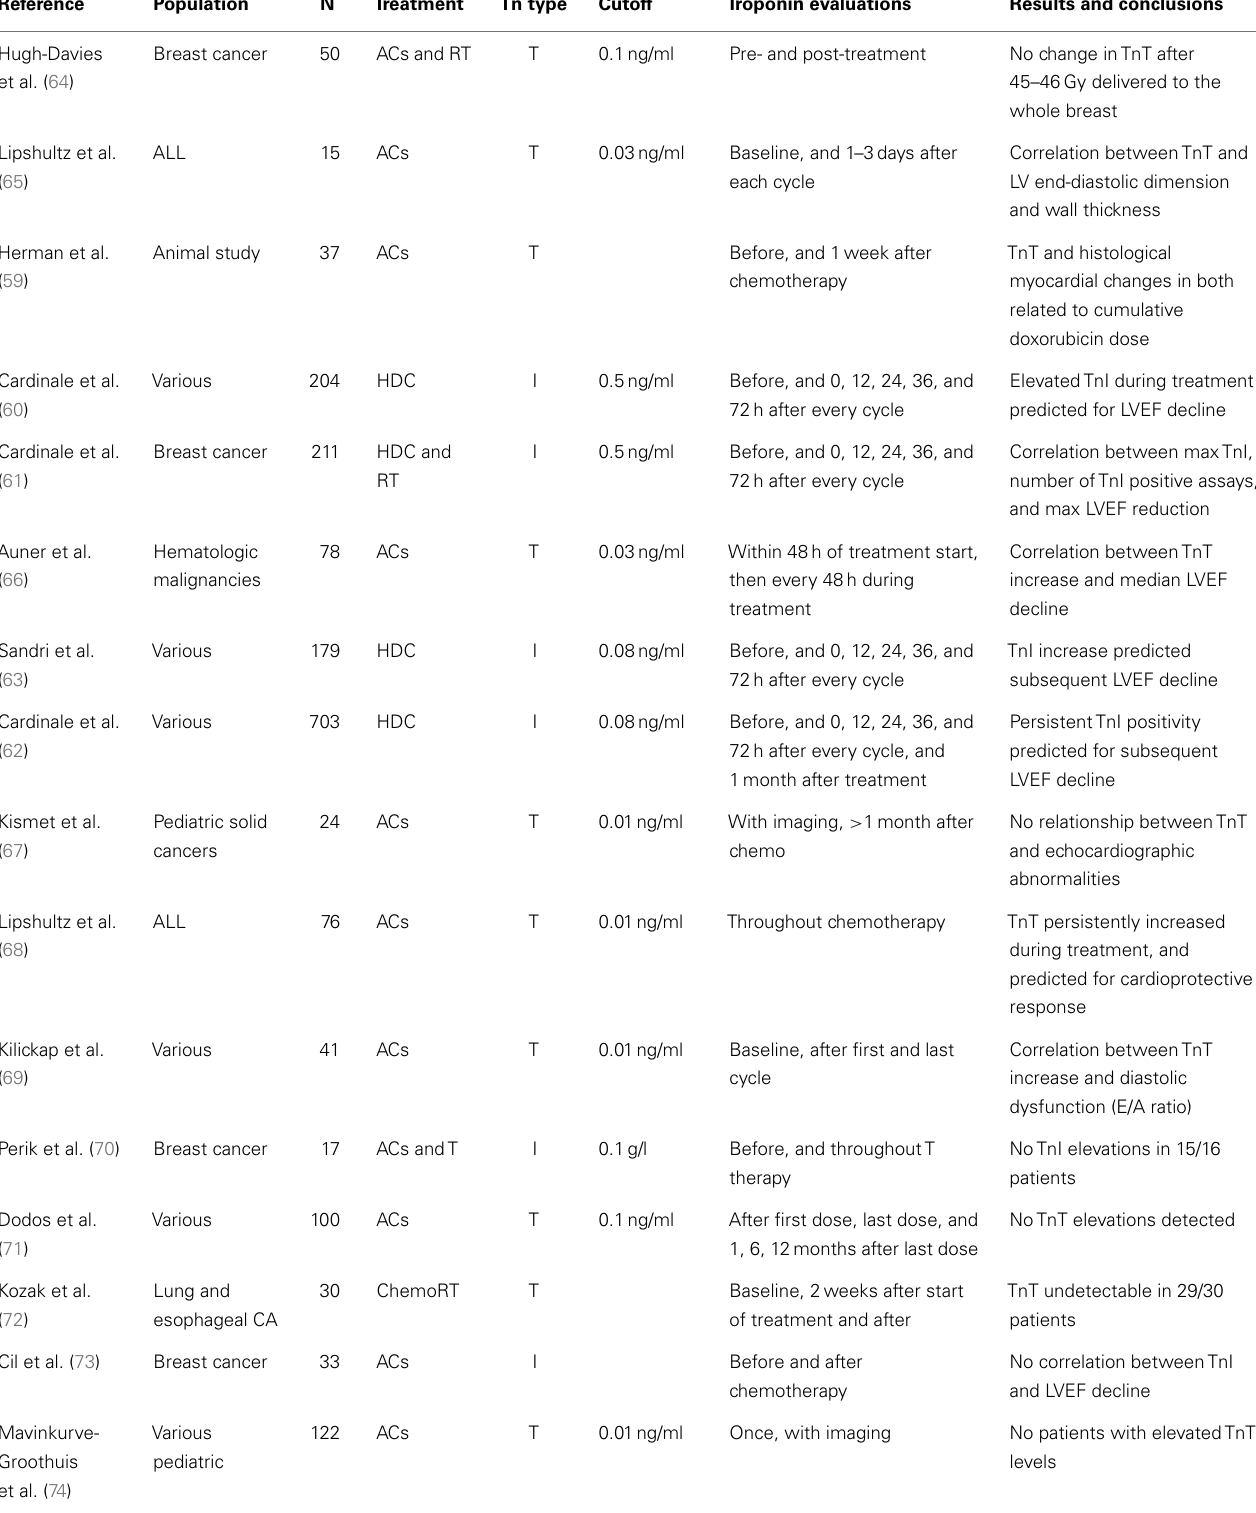
Table 1 | Role of cardiac troponins in the evaluation of chemotherapy and radiation-induced cardiotoxicity